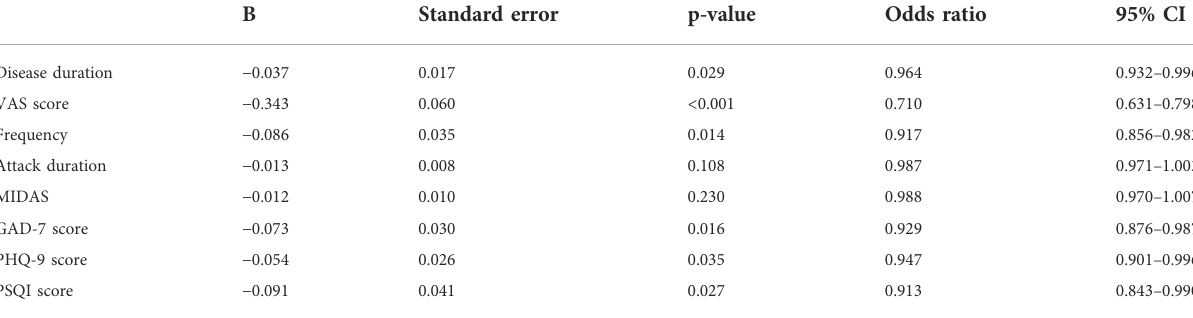
TABLE 2 Results of multivariable logistic regression